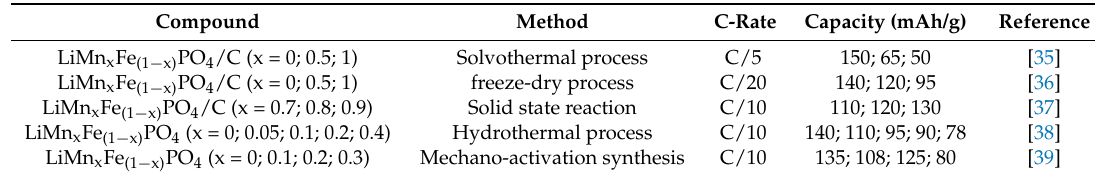
Table 6. Electrochemical performances of analogous LiMn x Fe (1 ´ x) PO 4 material described in the